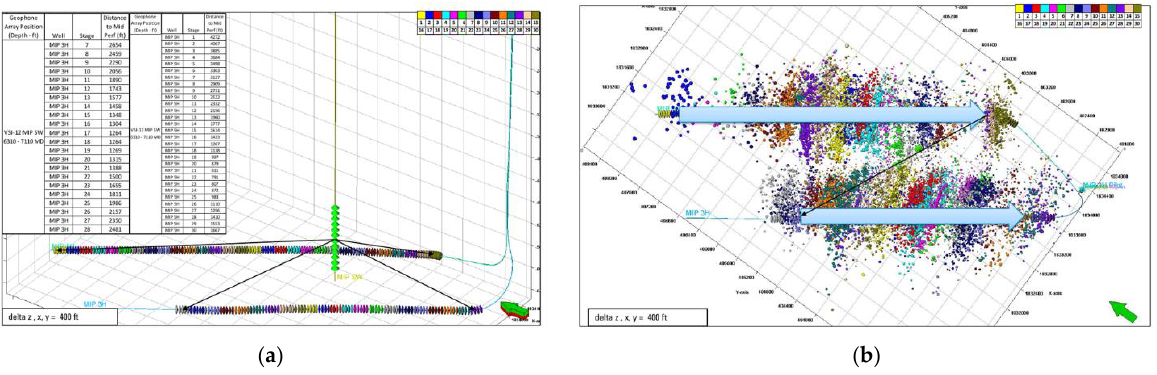
Figure 3. Schematic of the stages of the two MSEEL wells that were investigated in this study. ( a ) Stages of the two wells; ( b ) microseismic monitoring of the stages, color-coded by the stage number.